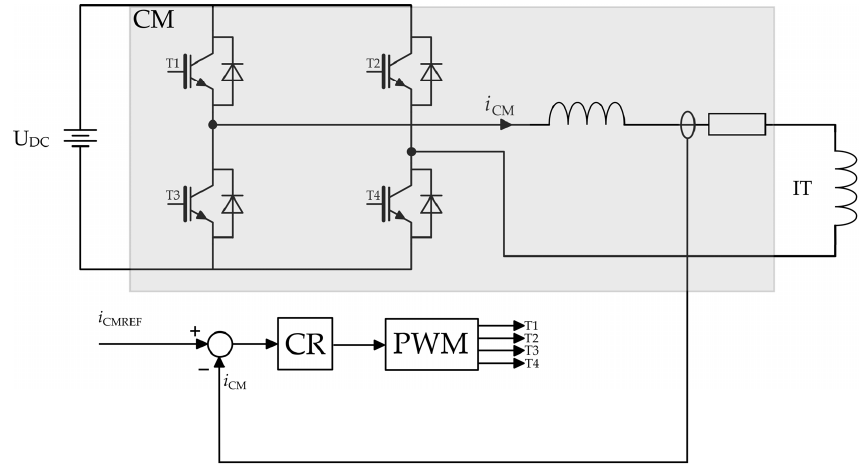
Figure 7. Schematic diagram of the current modulator based on the H-bridge structure with the output filter. Selected test results for the described method of implementing the current modulator